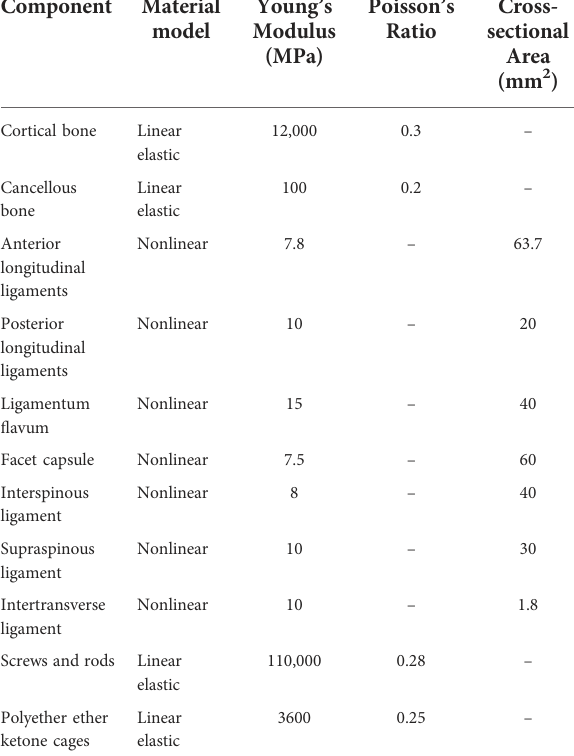
TABLE 1 Material properties of the fi nite element